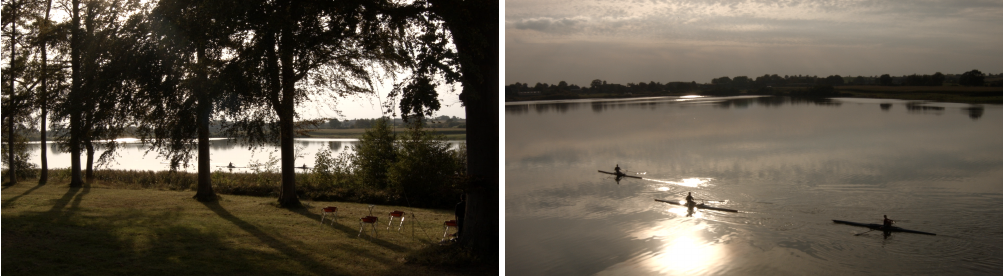
Figure 14. Experimental media production of a rowing race with two drones. The images are taken from the cameras on board the drones: the drone taking the lateral shot from the yard ( left ), and the drone taking the static shot after the fly-through ( right